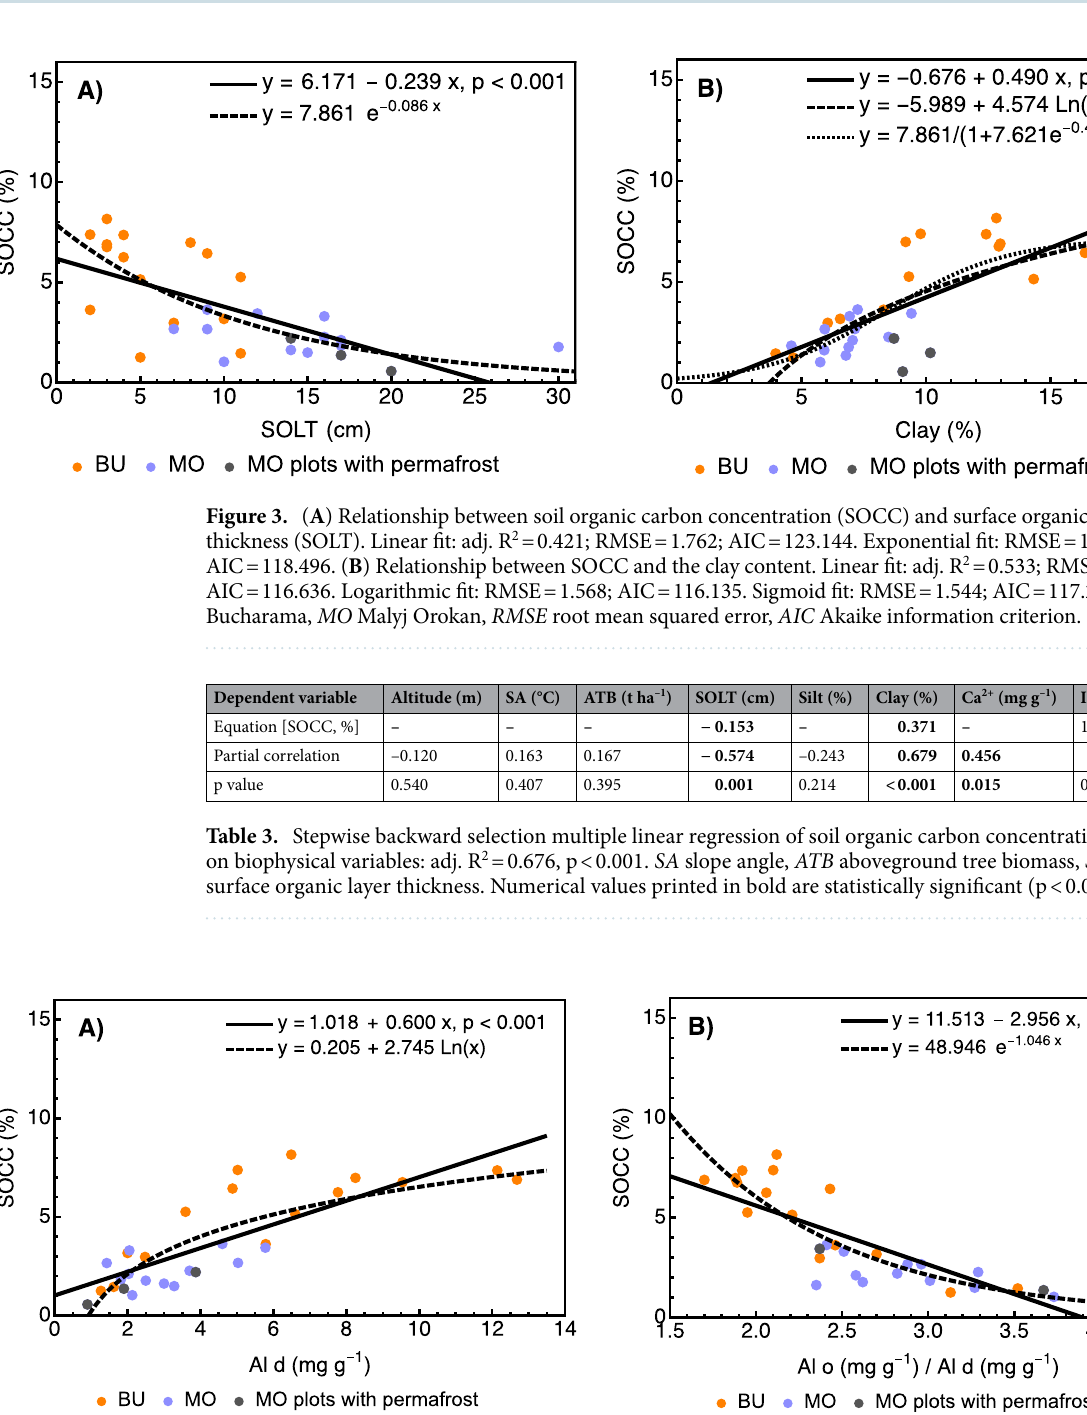
Figure 4. ( A ) Relationship between soil organic carbon concentration (SOCC) and the dithionite-extracted Al d. Linear fit: adj. R 2 = 0.637; RMSE = 1.396; AIC = 109.160. Logarithmic fit: RMSE = 1.358, AIC = 107.523. ( B ) Relationship between SOCC and the Al activity ratio (oxalate-extracted Al o/dithionite extracted Al d). Linear fit: adj. R 2 = 0.658; RMSE = 1.355; AIC = 107.361. Logarithmic fit: RMSE = 1.134; AIC = 96.693. BU Bucharama, MO Malyj Orokan, RMSE root mean squared error, AIC Akaike information